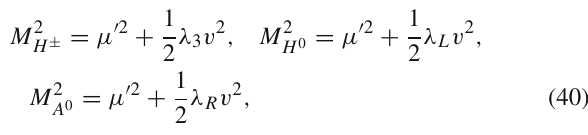
M H resonance pole and 2 2